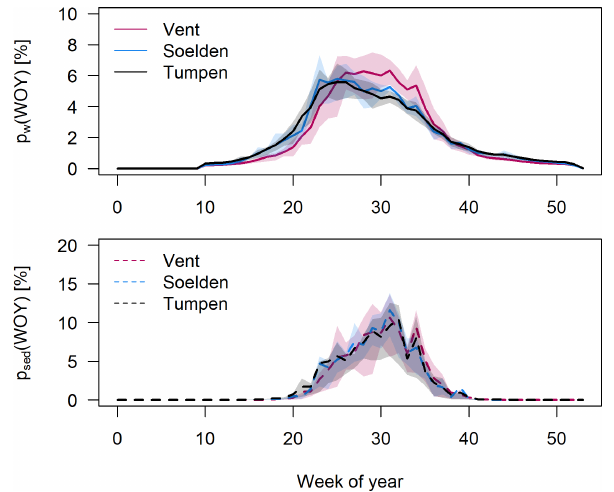
Figure 7. Seasonality illustrated by mean percentages of an- nual water yield ( p w (WOY)) and suspended sediment yield ( p sed (WOY)) per week of year at the three gauges. Lightly colored areas show interquartile ranges (i.e., 25% and 75% quantiles).